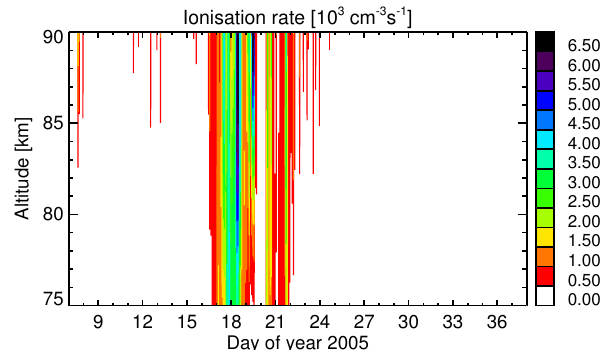
Fig. 2. Zonal mean ionisation rate due to precipitating protons and electrons averaged between 72–82 ◦ S for days 7–38 of year 2005 originating from the AIMOS model (Sect. 6.3).